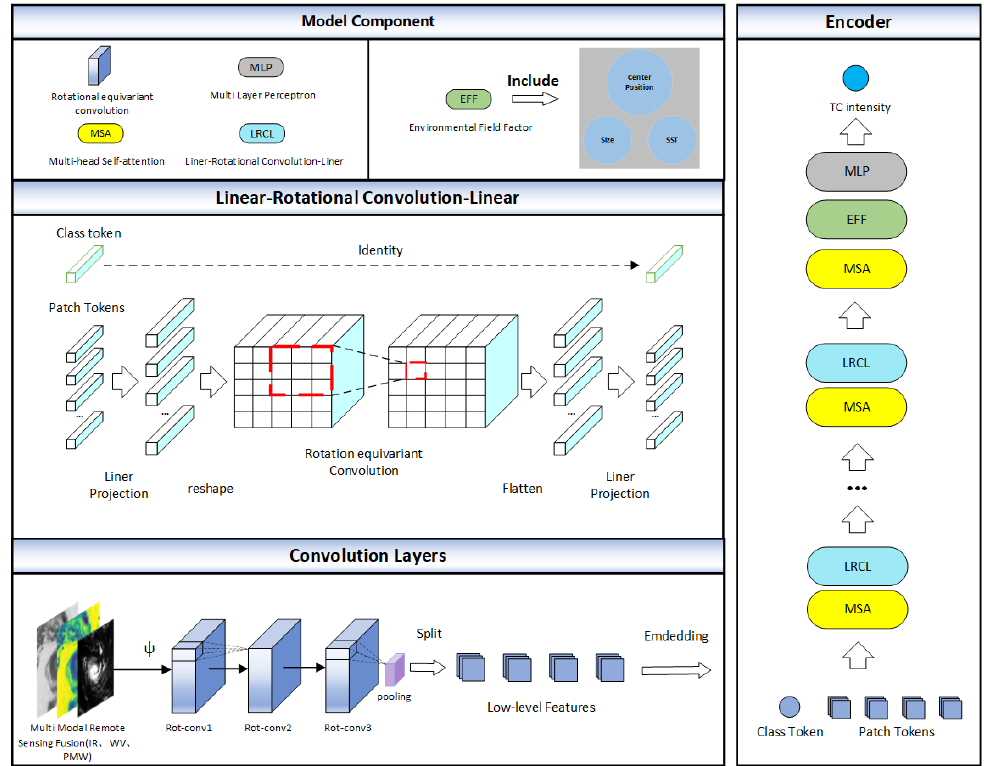
Figure 2. The specific parameter settings for the model are shown in Table 4, where one block consists of one MSA and one LRCL.